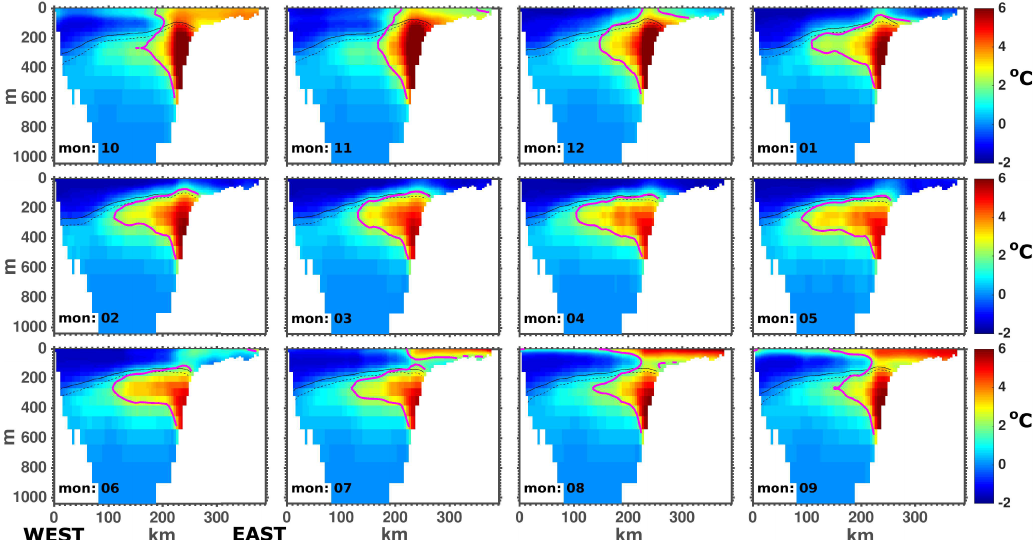
Figure 6. The monthly average temperature through the period of 2004 to 2010 at Davis Strait from HighRes. The magenta line represents the 2 ◦ C isotherm, the black line is the 34 . 0 salinity isohaline, and the dashed black line is the 34 . 2 salinity